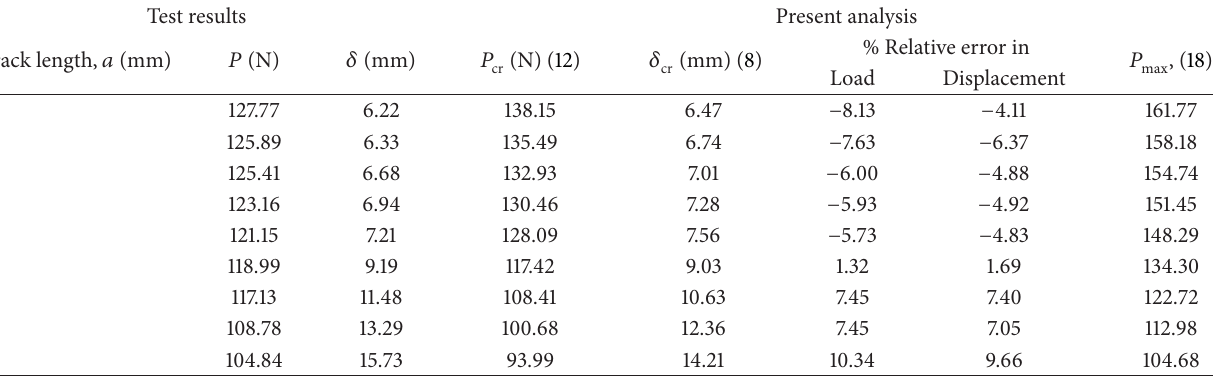
Table 1: Critical load, 𝑃 , and corresponding displacement, 𝛿 cr glass/epoxy composite.